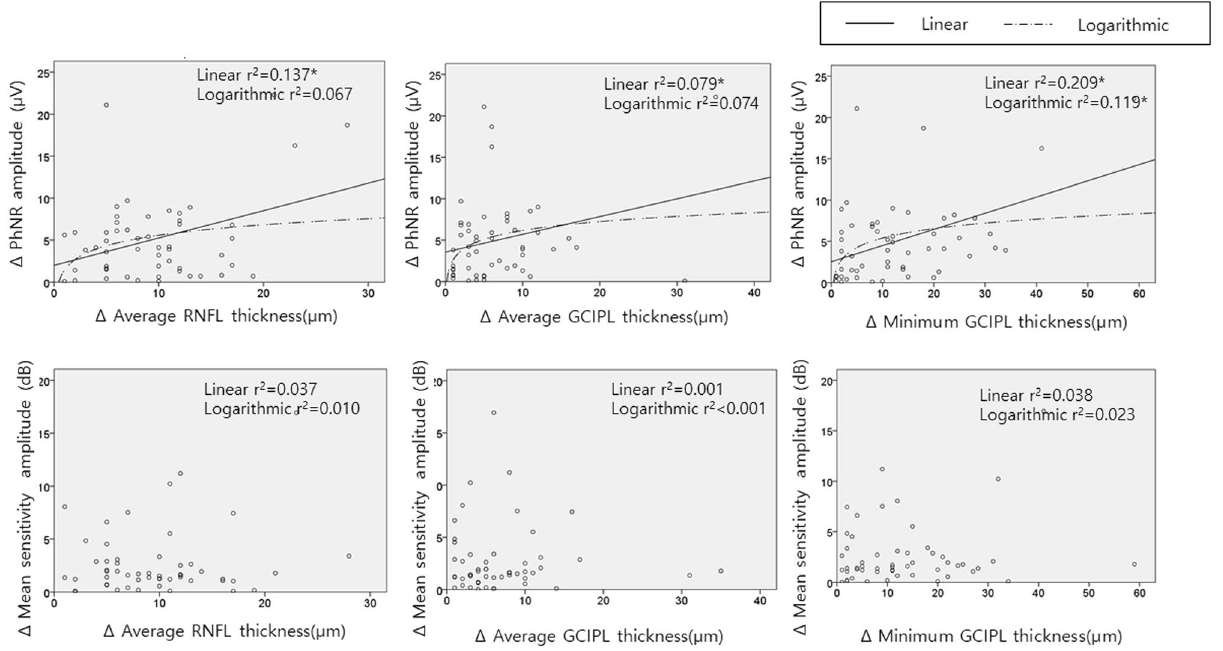
Figure 2. Scatter plots of interocular differences between photopic negative response (PhNR) and retinal nerve fiber layer (RNFL) thickness or ganglion cell-inner plexiform layer (GCIPL) thickness. *Regression analysis with P <